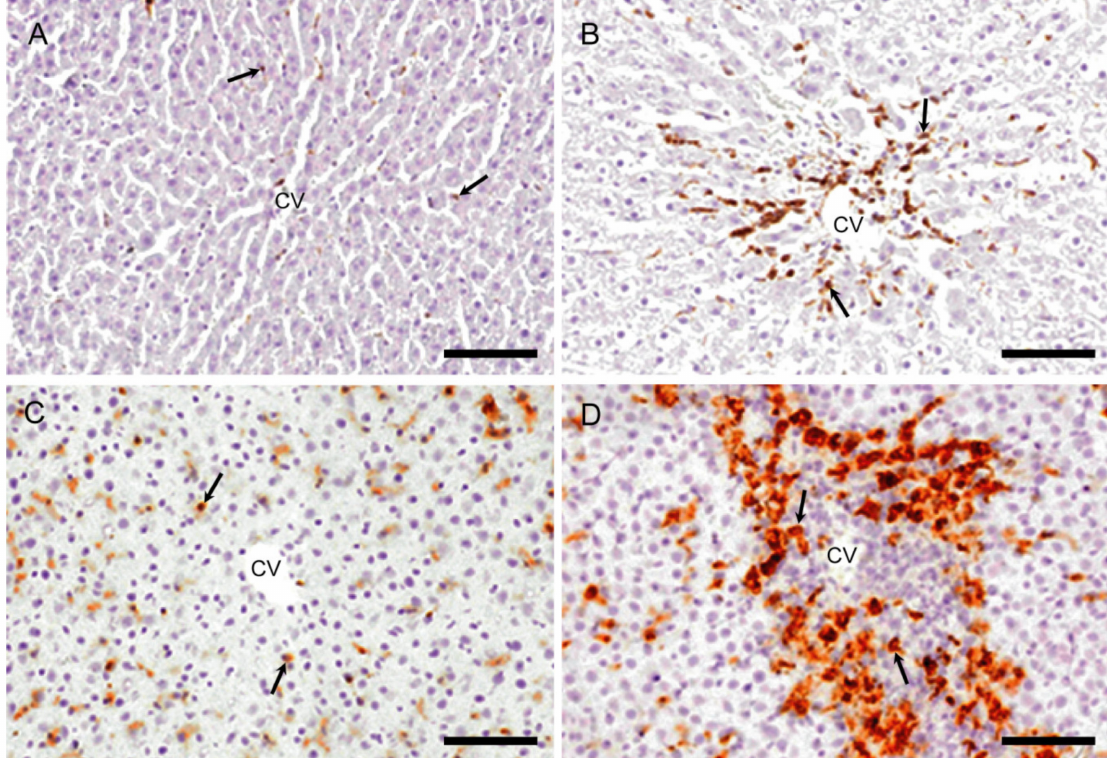
Figure 3. Immunohistochemistry for CD68 (M1-macrophages) and CD163 (M2-macrophages). In controls, very few macrophages positive for CD68 ( A ) are present and cells positive for CD163 ( C ) are seen along the sinusoids (indicative of Kup ff er cells). On day 2, the number of macrophages reacting to CD68 ( B ) and CD163 ( D ) is increased, showing di ff erent cell shapes to each other. Arrows indicate immunopositive cells. Immunohistochemical staining, counterstained with hematoxylin. CV, central vein. Bar = 50 µ